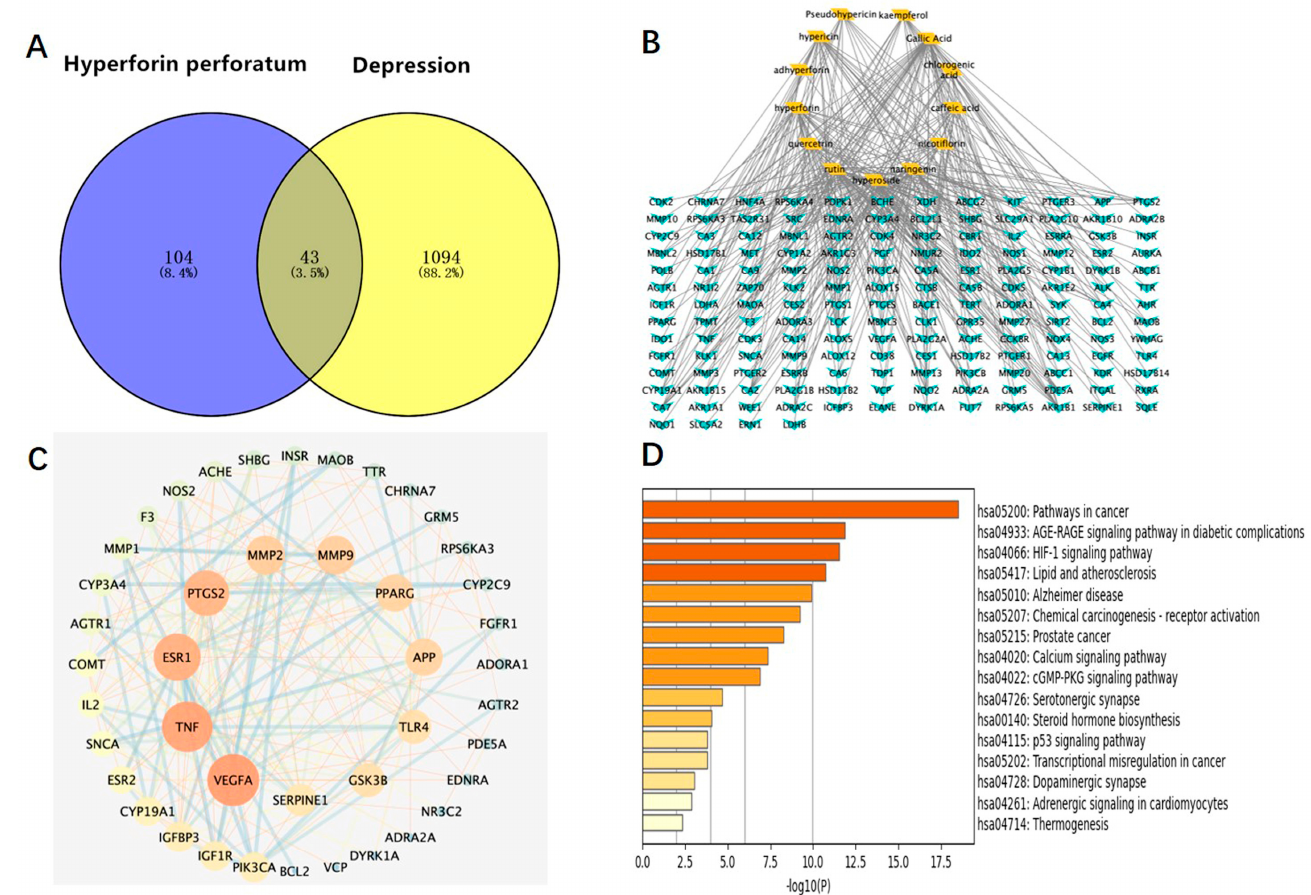
Figure 3. Network pharmacology map of the major active components of HP and depression. ( A ) Venn diagram of related targets of HP and depression. ( B ) The active components of HP and their corresponding anti-depression targets were imported into Cytoscape software to construct the net- work diagram of the target of the active component. ( C ) PPI network of overlapping targets between drug and disease; the size of the circle represents the target degree. ( D ) KEGG pathway analysis of intersection targets between the main components of HP and depression.